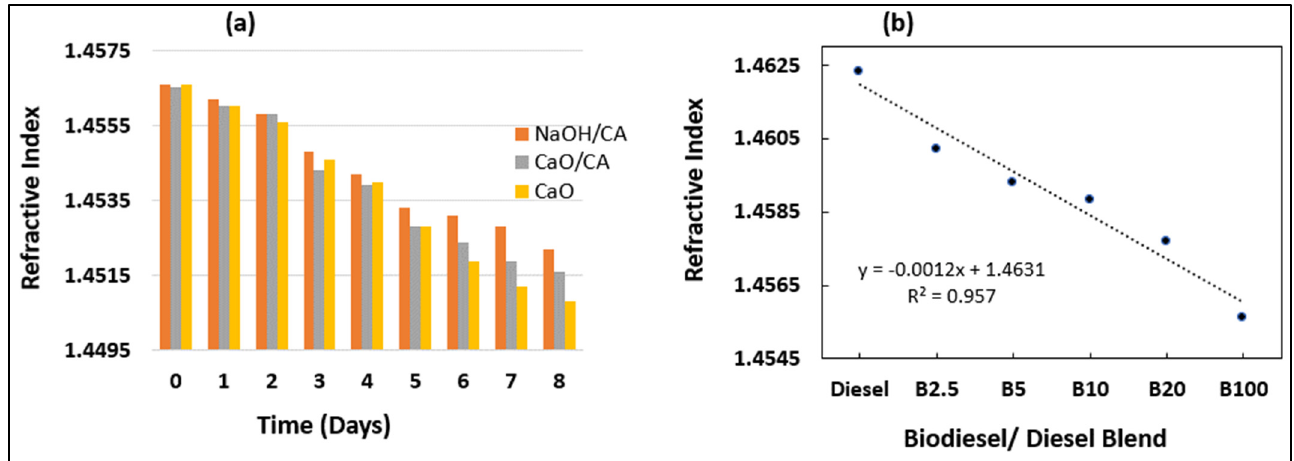
Figure 8. Refractive index of ( a ) biodiesel under accelerated storage, and ( b ) biodiesel, diesel and biodiesel/diesel blends.